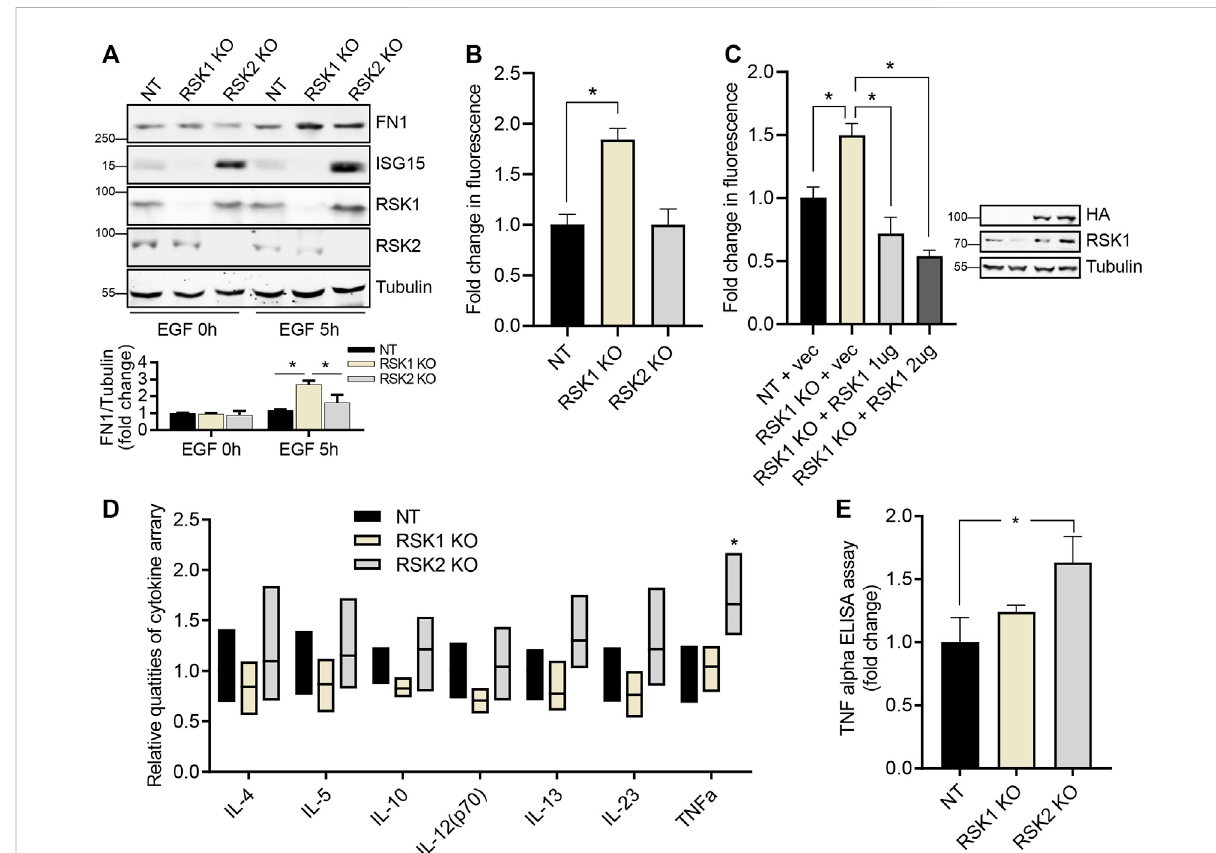
FIGURE 4 RSK1 regulates cell adhesion while RSK2 regulates immune response. (A) Representative western blot analysis of three cell lines in 0.1% FBS starved conditions, and after EGF stimulation. Tubulin was used as an internal control. Expression intensity of FN1 was quanti fi ed using ImageJ (bottom). (B) Cell adhesion assay shows the in vitro binding pro fi le of NT, RSK1 KO and RSK2 KO cell lines. Calcein-AM staining of bound cells were measured and quanti fi ed. (C) Cell adhesion assay of restored RSK1 expression in RSK1 KO cell lines. Two different amounts of RSK1 was transiently transfected in RSK1 KO cell lines for the assay. The expression of RSK1 was con fi rmed by western blot analysis (right). (D) Bar graph showingthesevenquanti fi